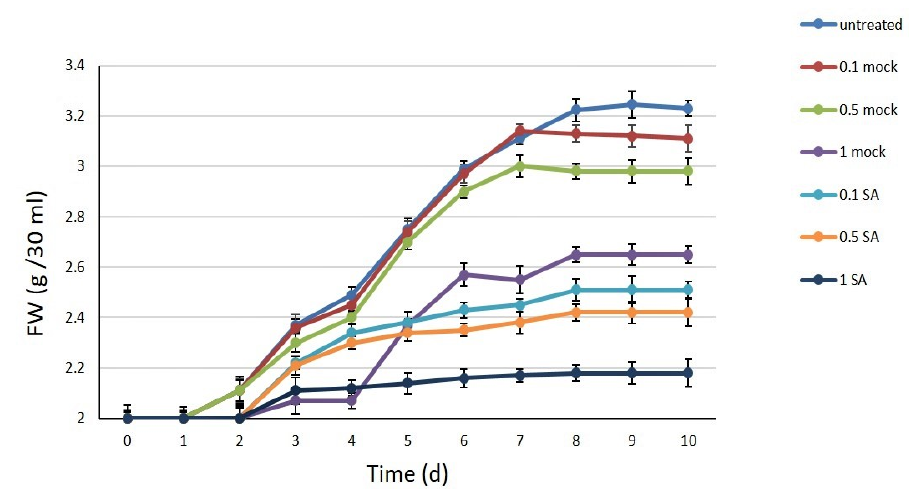
Figure 1. Growth curve of sa ff ron cell cultures within 10 days. Untreated, without methanol or salicylic acid (SA); mock 0.1, 0.5, and 1; SA 0.1, 0.5, and 1 mM treated cells. Values are reported as the average of three replicates ± standard